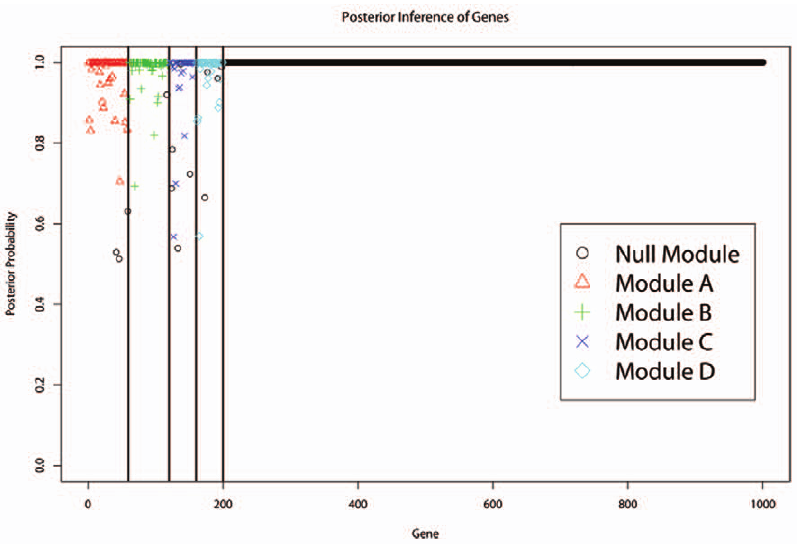
Figure 4. The posterior probability plot. The height of each point is the posterior probability for the most likely classification of the gene; and the shape/color of the point represents the module type of the classification. The first 200 genes are those in one of the four non-null modules, separated by vertical lines.